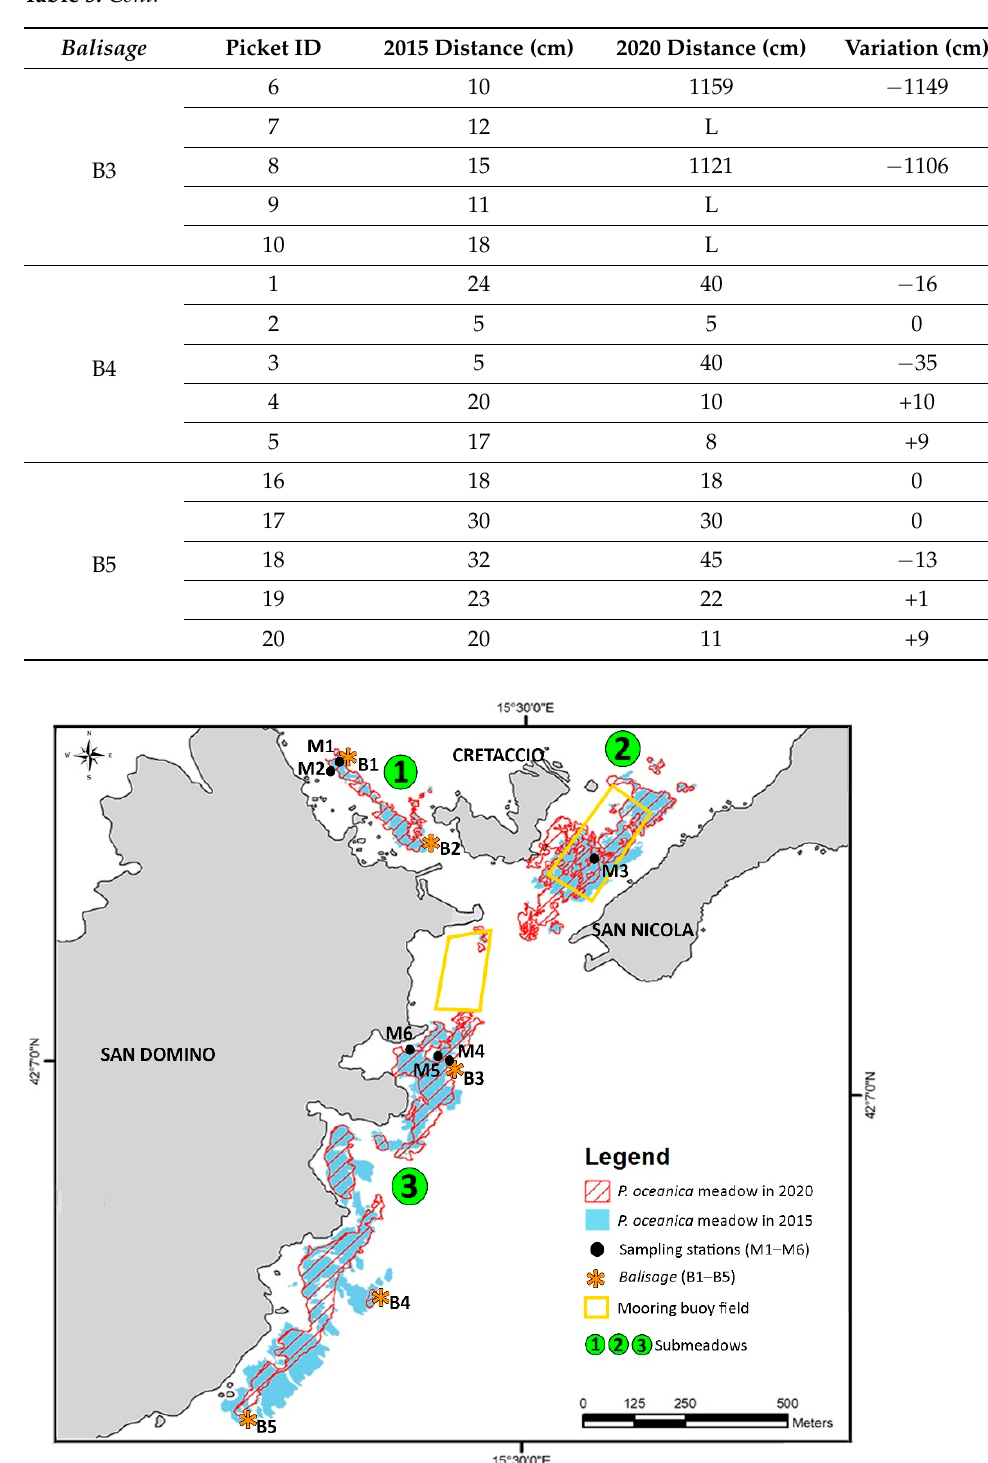
Figure 4. Map of the Posidonia oceanica meadow at the Tremiti Islands in 2015 and 2020. Sampling stations, balisage systems, and mooring buoy fields are also reported. Table 5. Distance (cm) between each of the five pickets per balisage system (B1–B5) and the closest Posidonia oceanica rhizomes at the lower limit of the meadow in 2015 and 2020. L: picket lost.